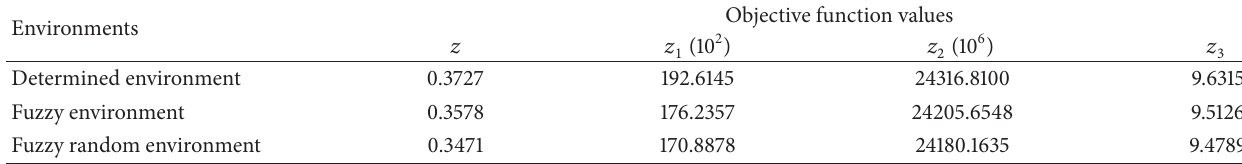
Table 12: Model comparison in different environments.